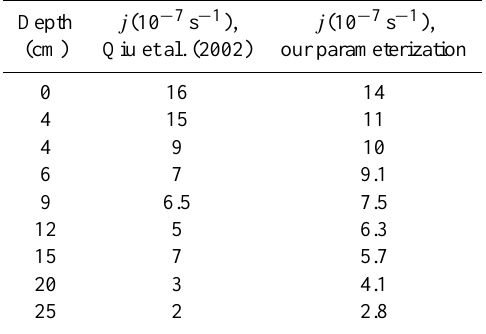
Table D4. Noon time, mid-June Summit, Greenland, nitrate photolysis rates calculated in Qiu et al. (2002) compared to nitrate photolysis rates calculated using our